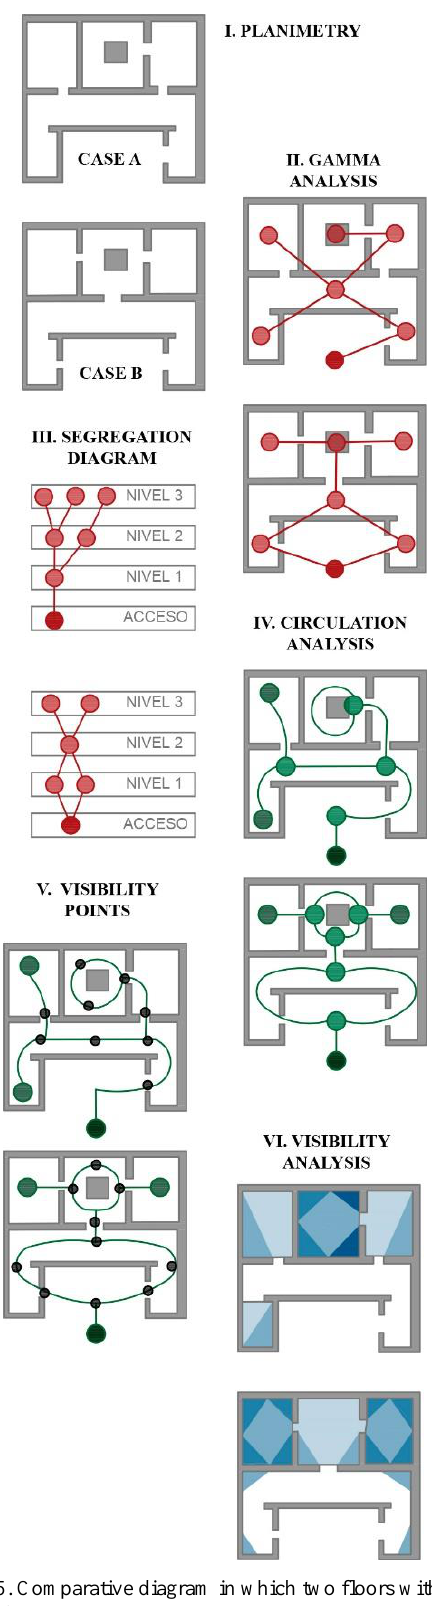
Figure 5. Comparative diagram in which two floors with a very similar formal appearance are presented. From an architectural view they would be interpreted in the same way, given their dimensions and their square floor plan; however, in producing its spatial analysis, it is possible to see the different results that highlight the importance of this type of analysis in the architectural studies of historical